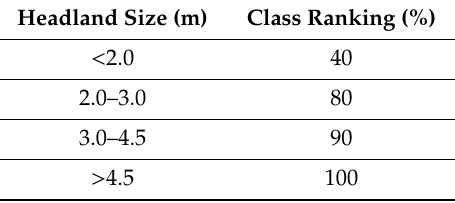
Table 3. Categorisation by operating space of the width of the headland in Italian vineyards.